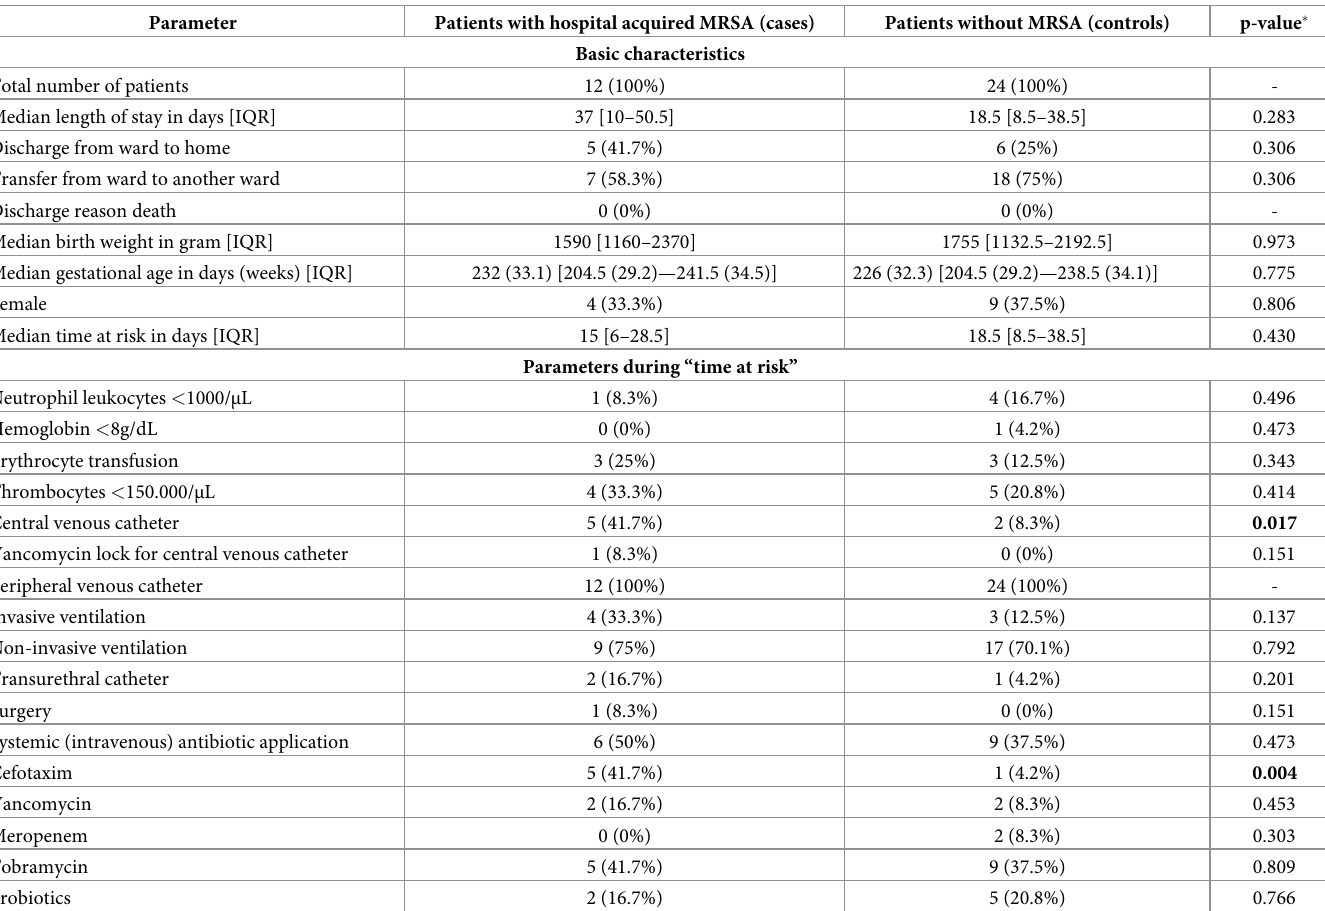
Table 2. Comparison of patients with hospital acquired MRSA (cases, n = 12) and without MRSA (controls, n = 24)—matched case control study. Parameter Patients without MRSA (controls) p-value